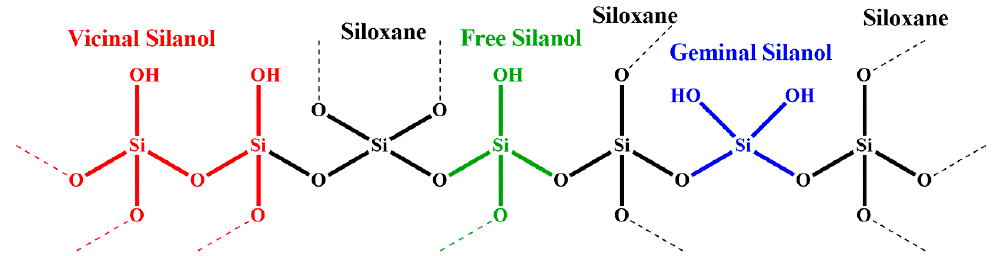
Figure 1. Silicon–oxygen group types present in SBA-15 and KIT-6.